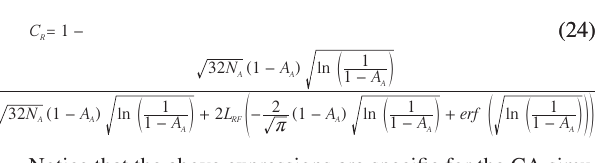
Figure 6. Total interface length per unit of area, L Simulation results are in agreement with those calculated from the kinetics of a single grain, Equation